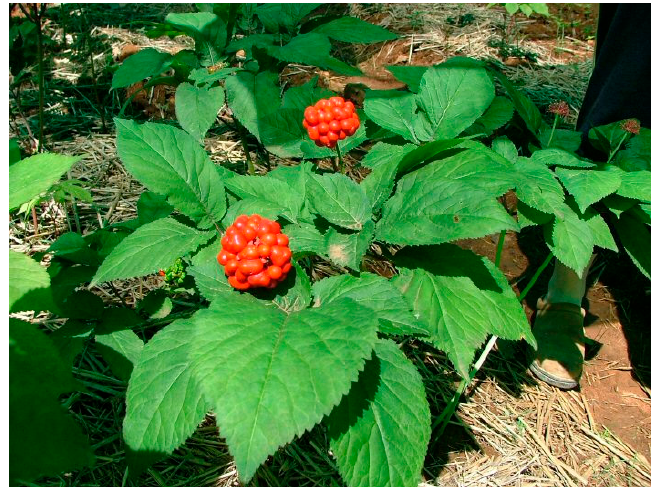
Figure 5. Panax ginseng C.A Meyer.